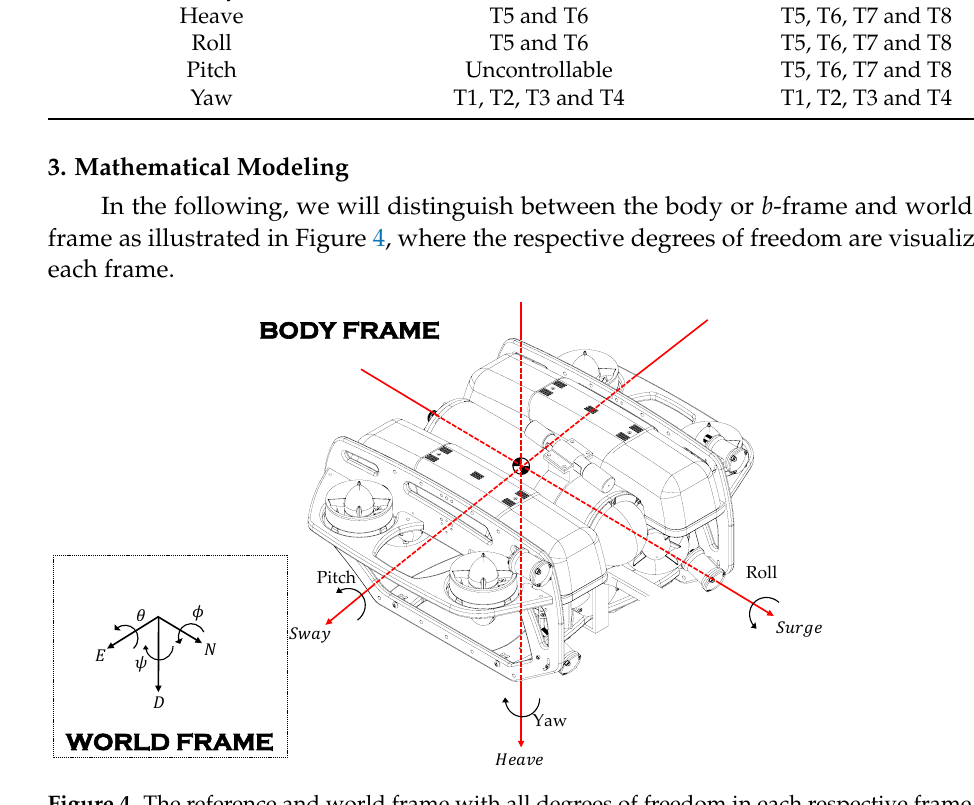
Figure 4. The reference and world frame with all degrees of freedom in each respective